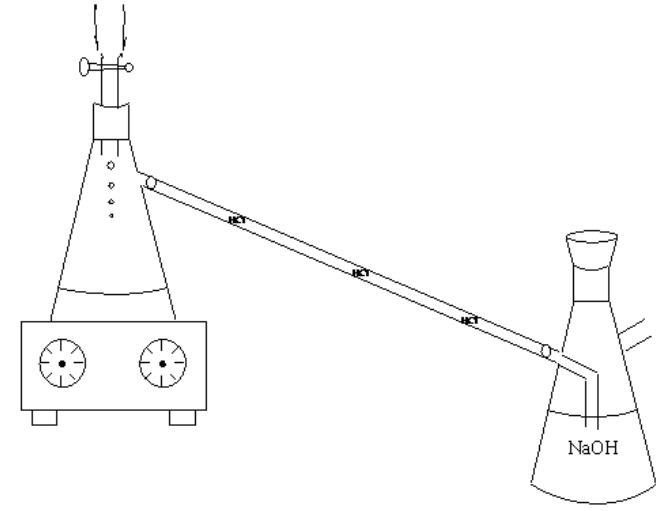
Figure 2. Demonstration of Friedel-Crafts reaction in the presence of Lewis acid.